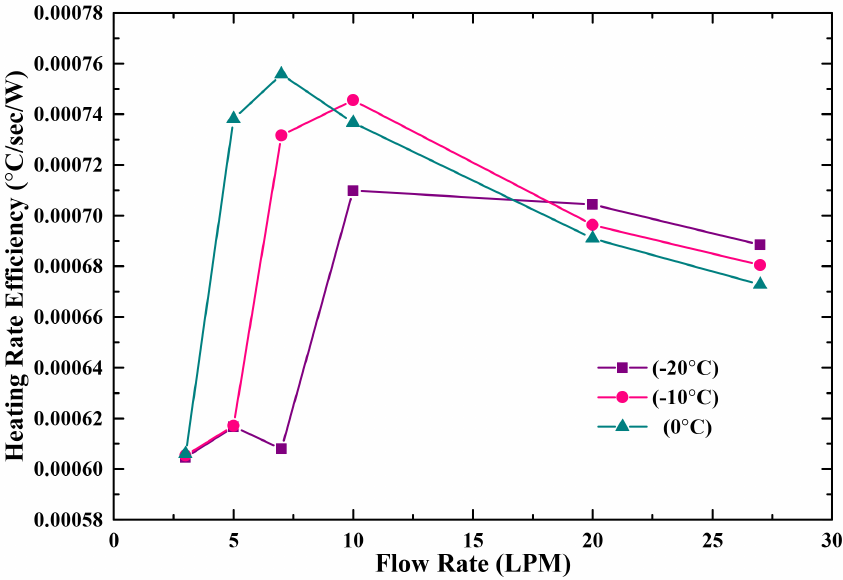
Figure 15. System overall efficiency with heater capacity: 2